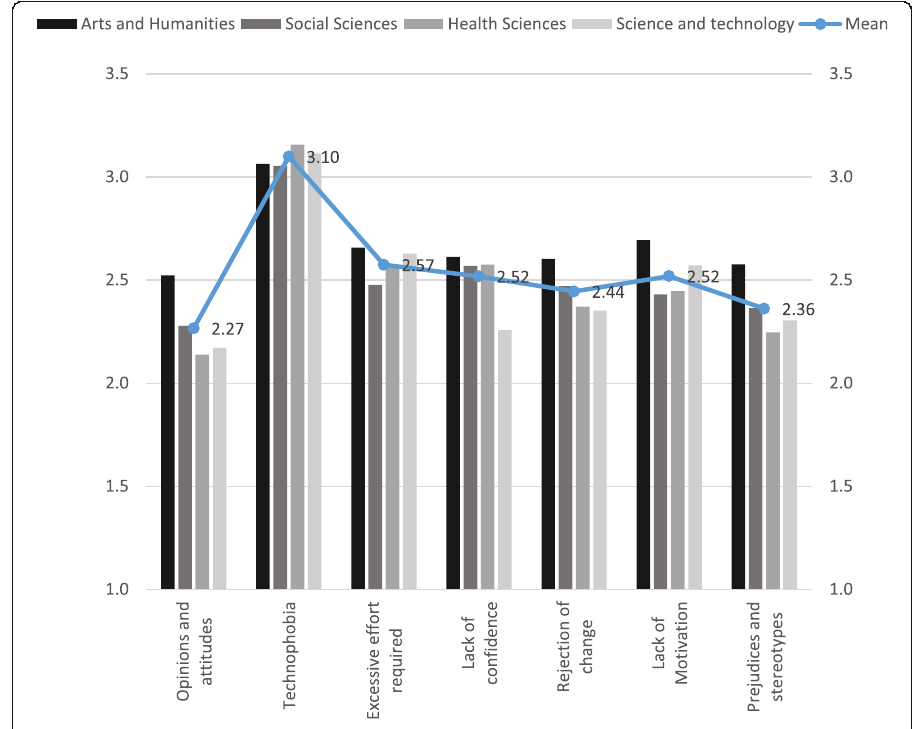
Fig. 2 Mean ranking for personal barriers to DT integration according to academic discipline